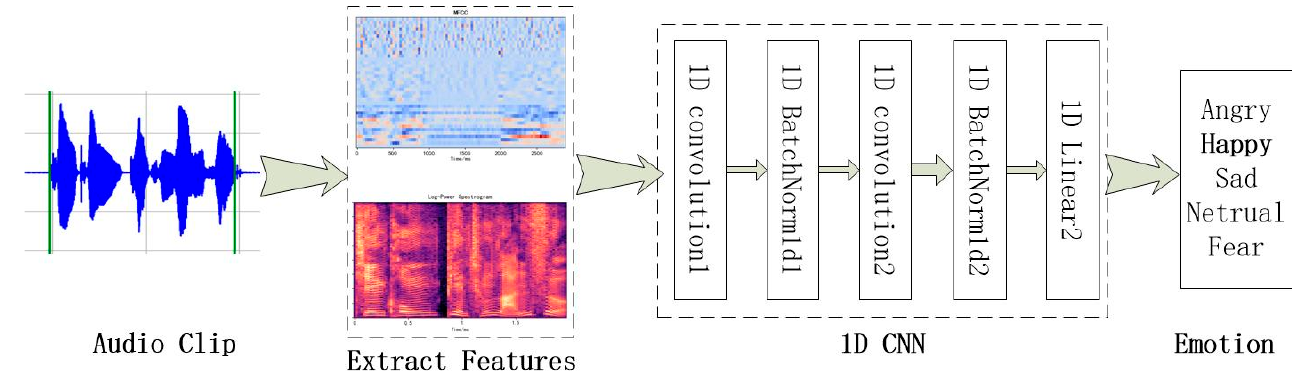
Figure 3. Structure of CNN.